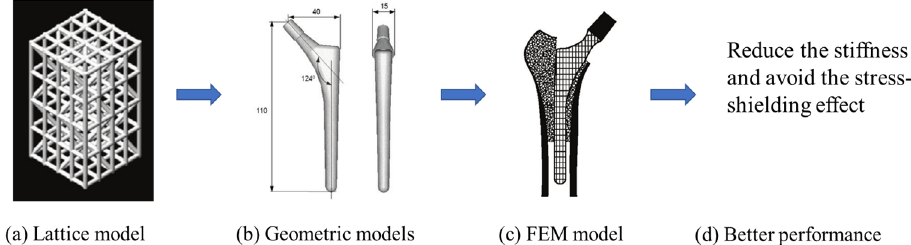
Figure 1. An example of obtaining better performance by designing a new structure. Adapted from reference [6].